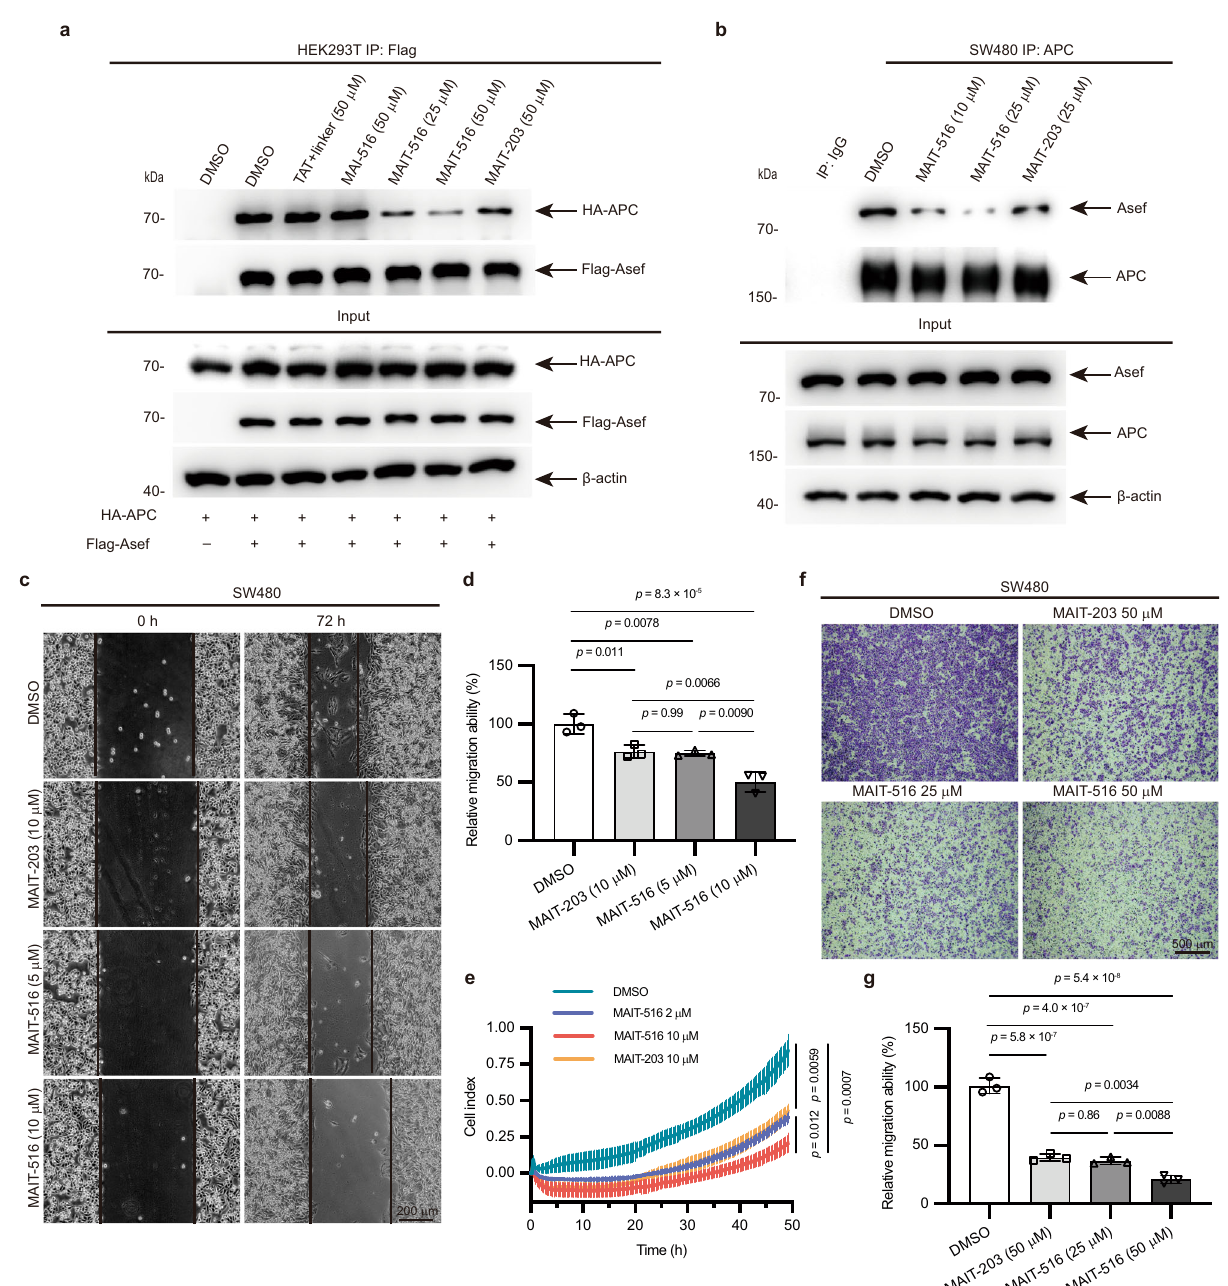
Fig. 4 | MAIT-516 inhibits the migration of SW480 cells by disrupting the APC – Asef PPI. a Co-IP of exogenous HA – APC (303 – 876) and Flag – Asef (170 – 632) inHEK293TcellstreatedwithDMSO,TAT+linker(50 μ M),MAI-516(50 μ M),MAIT- 516 (25 μ M and 50 μ M), and MAIT-203 (50 μ M)for 24h. b Westernblot analysis for Co-IPwithanti-APCantibodyinSW480cellstreatedwith10 μ Mor25 μ MMAIT-516. Full blots are provided in Source Data fi les. All co-IP experiments were repeated three times with similar results. c , d Representative images c of the wound-healing assays of SW480 cells treated with DMSO, MAIT-516, or MAIT-203 for 72h. The images shown are representative of triplicate experiments. Scale bar: 20 μ m. Quantitative cellmigration data d are expressedrelative to the migration ability of the DMSO-treated group. Data are represented as the mean±SD (n=3 indepen- dentexperiments). e KineticcurvesofthemigrationofSW480cellsaftertreatment with DMSO, MAIT-516orMAIT-203 asassessed by xCELLigenceRTCA-DP.Data are